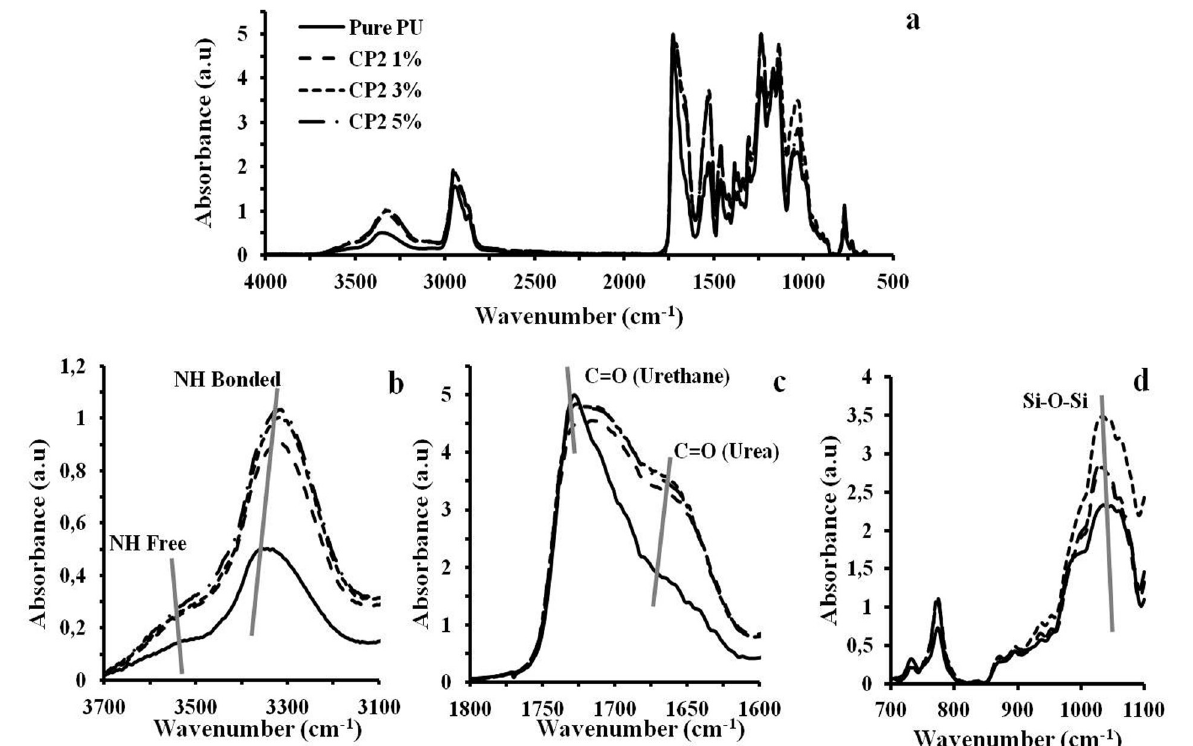
Figure 2 - FTIR spectra of the pure PU and CP2 composites ( a ); zoom in the region of Nh band ( b ); zoom in the C=O band and ( c ) zoom in the region of Si-Oh,